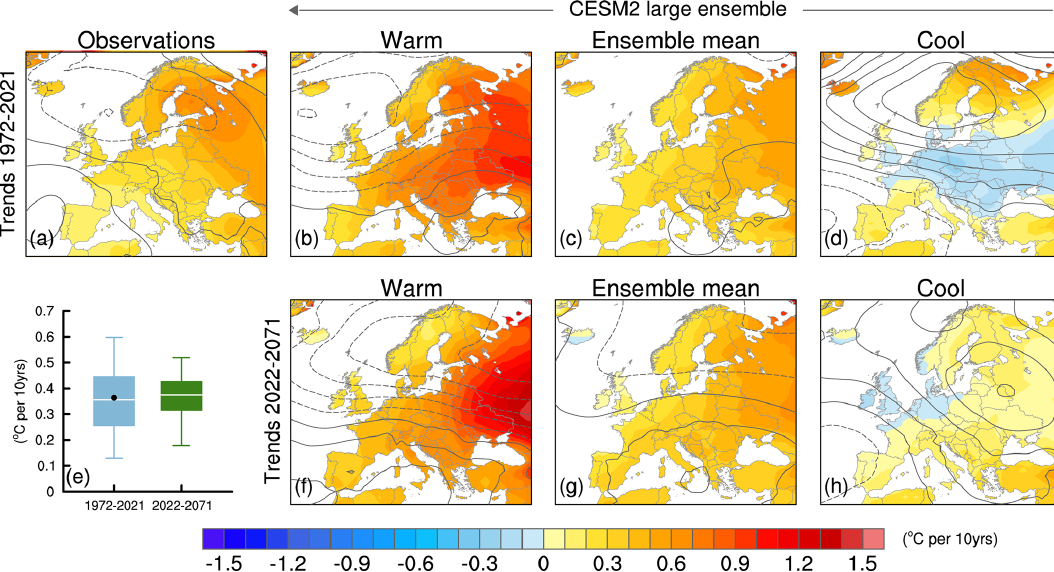
Figure 10. A range of outcomes. Trends in winter air temperature (color shading; ◦ C per decade) and sea level pressure (SLP) (contours; contour interval of 0.25hPa per decade; negative values dashed) for the period (a–d) 1972–2021 and (e–h) 2022–2071. Panel (a) shows observed trends (1972–2021), and remaining panels show simulated trends from the 100-member CESM2 large ensemble. (c, g) Ensemble mean. (b, f) Warm end-member. (d, h) Cool end-member. See text for details. Note that panels (a) and (c) are identical to the OBS and EM panels in Fig. 1, respectively. (e) Distribution of European-averaged trends for 1972–2021 (blue) and 2022–2071 (green) from the CESM2 large ensemble (the box outlines 25th–75th percentile range, whiskers mark the 5th–95th percentile range, the horizontal white line denotes the median value, and the black circle marks the observed value).